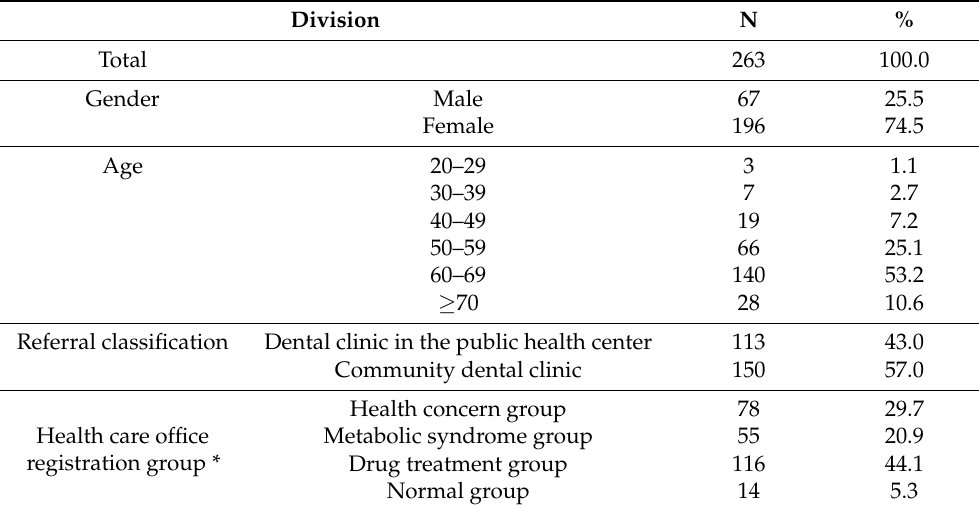
Table 1. General characteristics of subjects.